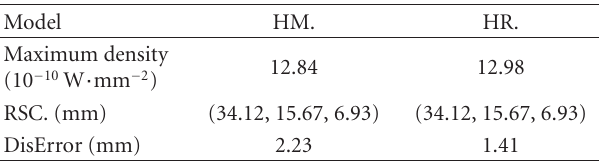
Table 2: Comparison of CLT with and without optical property priors. Model HM.